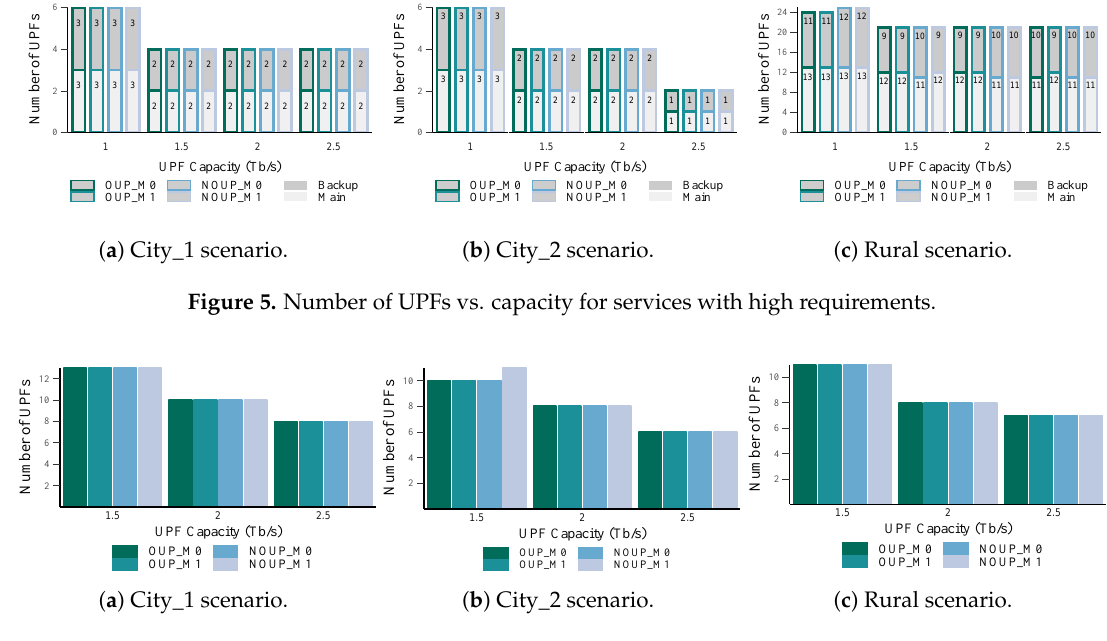
Figure 6. Number of UPFs vs. capacity for services with low